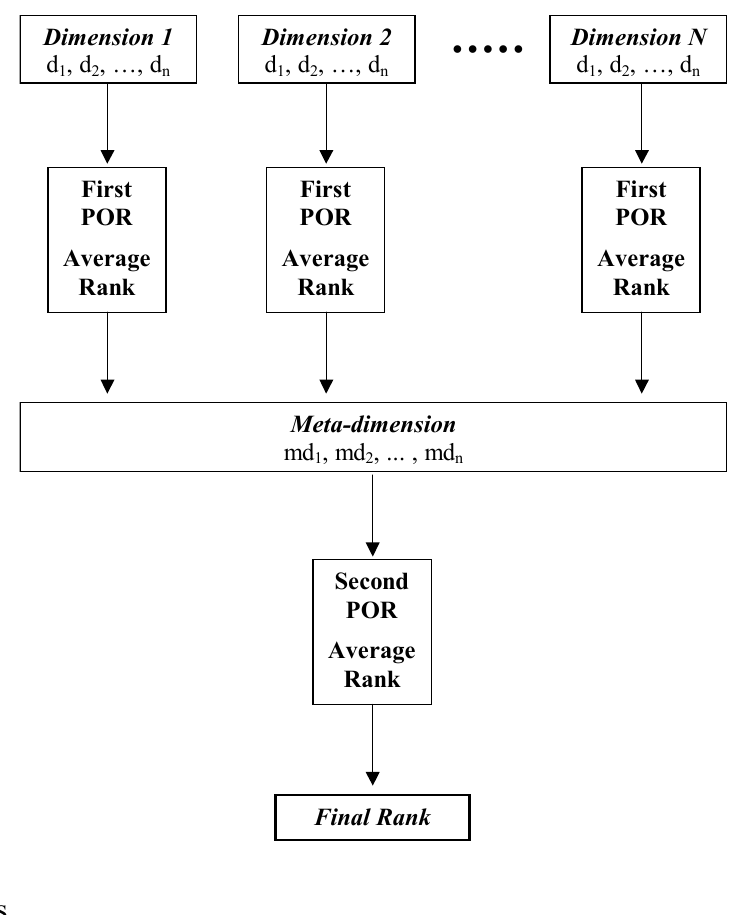
Figure 7 . Graphical representation of the hierarchical partial order ranking